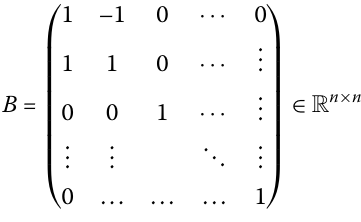
Therefore f is strongly convex.